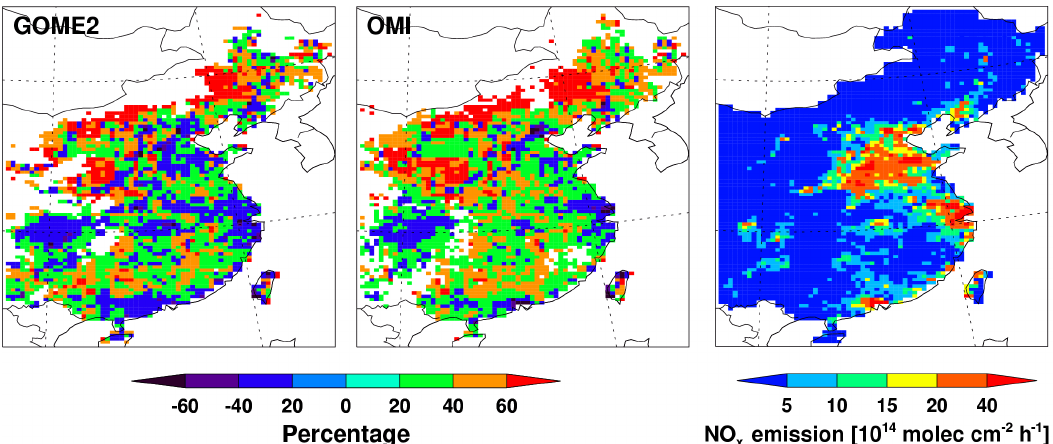
Figure 2. Relative difference between monthly mean local derivative ratio α ∗ and bulk ratio α , defined as 1 − α/α ∗ , for GOME-2 (left) and OMI (middle) in REAM simulations. The right panel shows NO x emission distribution estimated from GOME-2 observations by using the local derivative method over eastern China for August